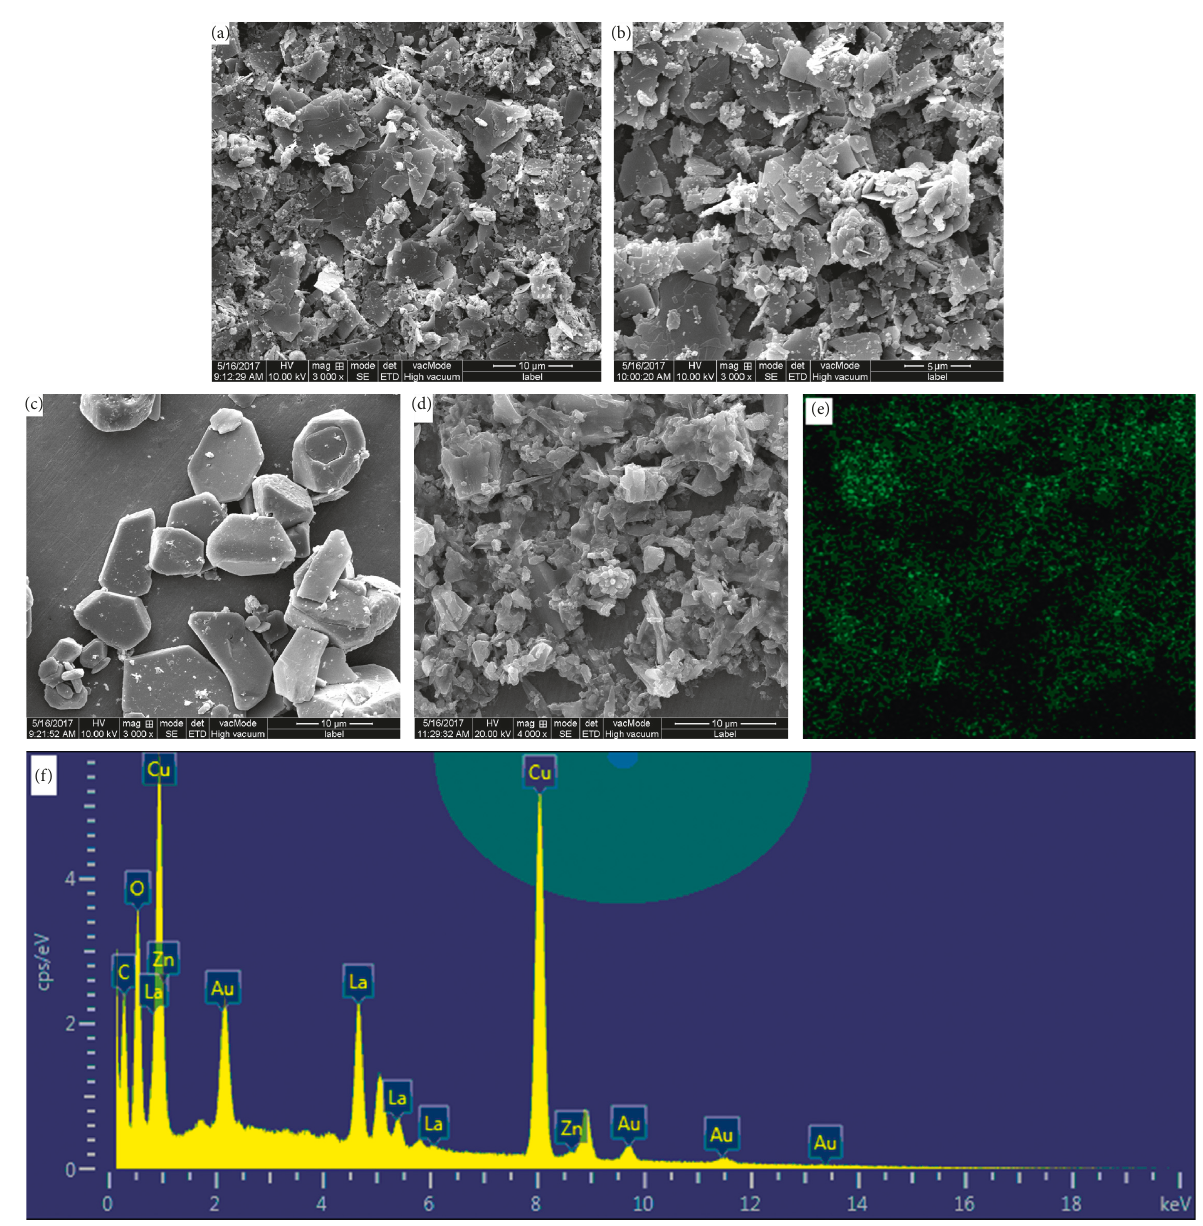
Figure 4: SEM of